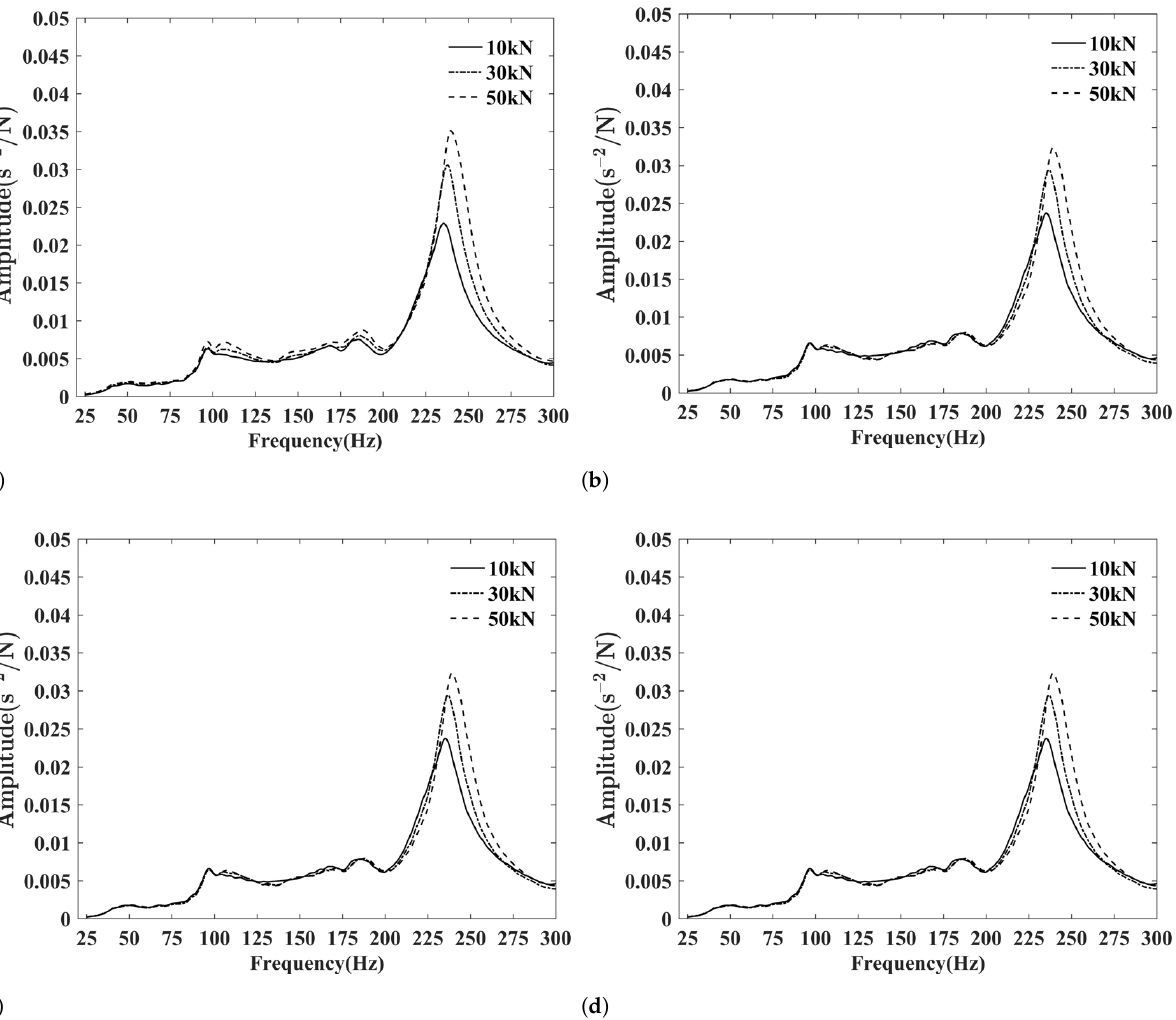
Figure 4. Responses of different static thrusts while: ( a ) at rotational speed 60 rpm; ( b ) at rotational speed 100 rpm; ( c ) at rotational speed 160 rpm; ( d ) no